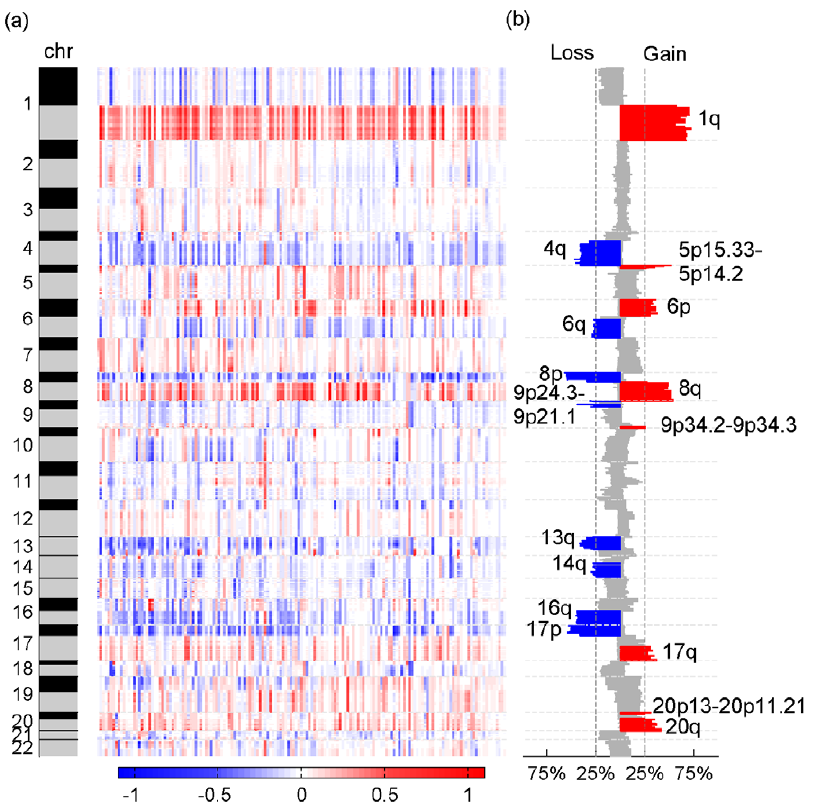
Figure 2. Profile of chromosomal alterations in all HCC samples (n=159). (a) , heatmap of CNAs across all chromosomes. (b) , the frequencies of CNAs across all chromosomes. Copy number gain and loss events of chromosomal segments were determined using log2-transformed ratio thresholds of 0.141 and 2 0.136 derived from the k-means clustering analysis. The color brightness is directly proportional to the frequency of CNA. Color red represents copy number gain and color blue represents copy number loss. CNA: copy number alteration.